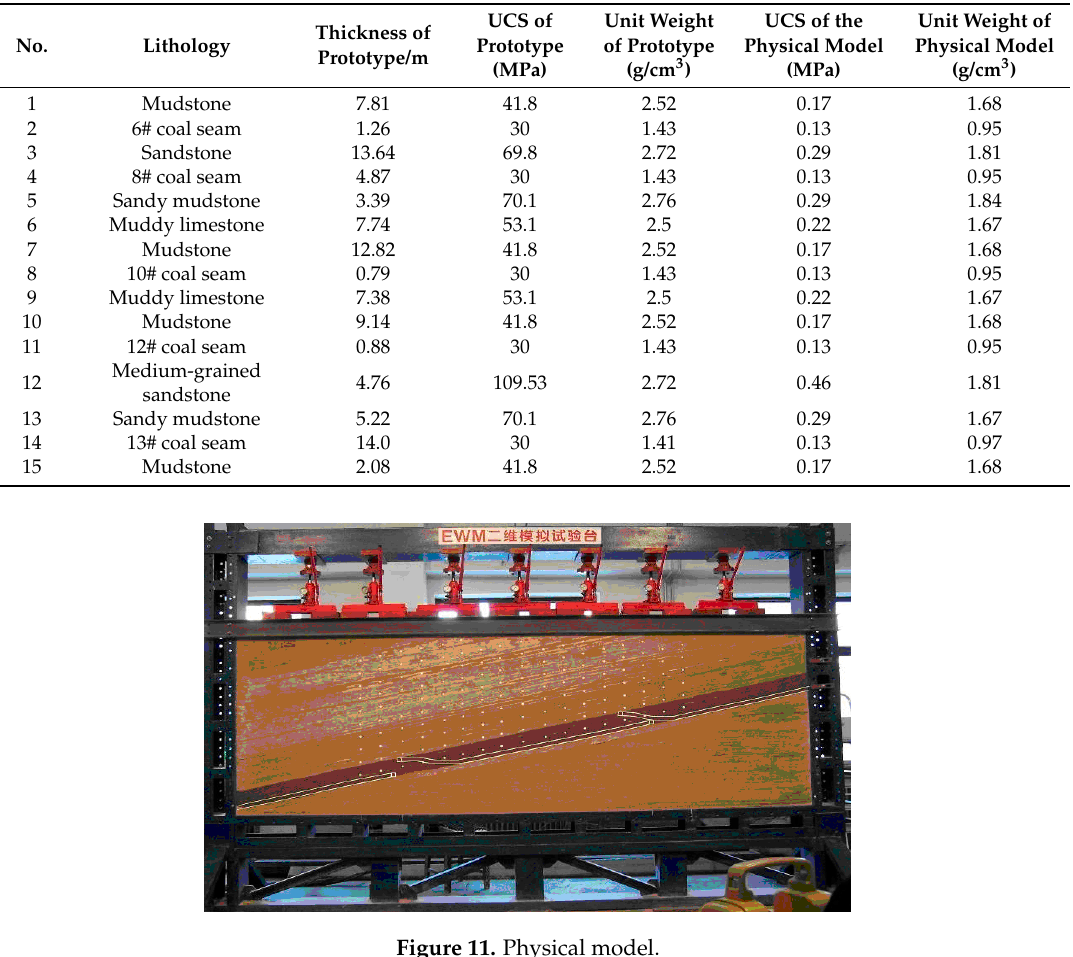
Table 4. Parameters of materials for physical modeling.